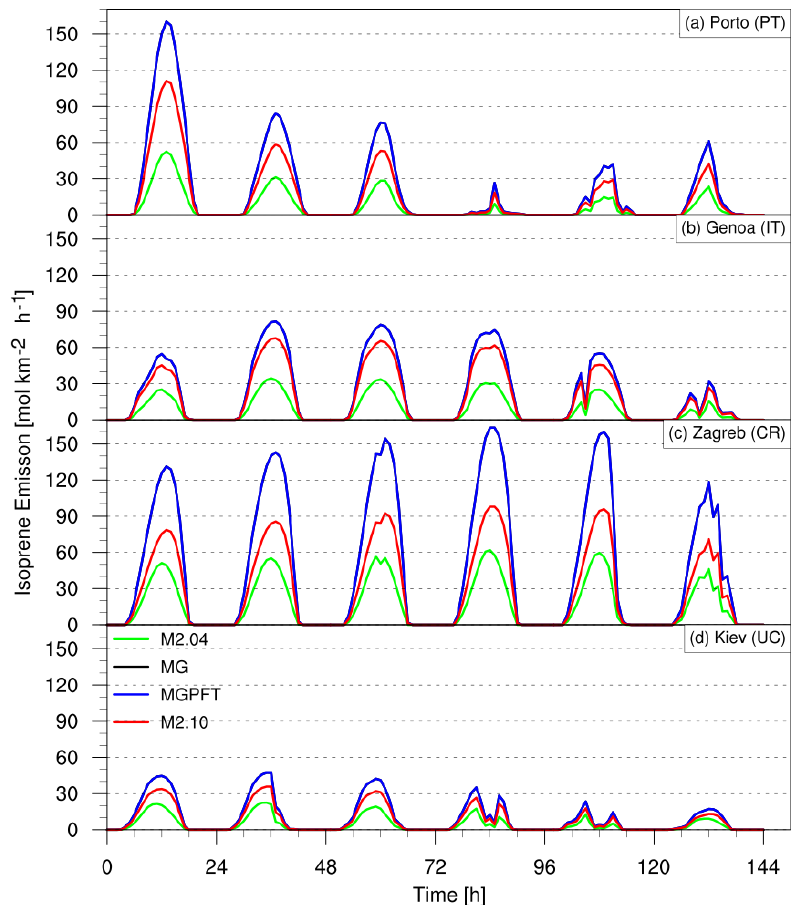
Figure 7. Time series of isoprene emissions (molkm − 2 h − 1 ) for different MEGAN algorithm configurations evaluated in four cities in Europe: (a) Porto, Portugal; (b) Genoa, Italy; (c) Zagreb, Croatia; (d) Kyiv, Ukraine. The time period considered is from 10 August 2015 at 00:00UTC to 16 August 2015 at 00:00UTC. The green lines represent the control simulation (M2.04), the black lines indicate the activity factor ( γ ) updates (MG), the blue lines are representative of the PFT emission factor updates (MGPFT), and the red lines show the isoprene emission factor as the emission factor of all the other compound classes